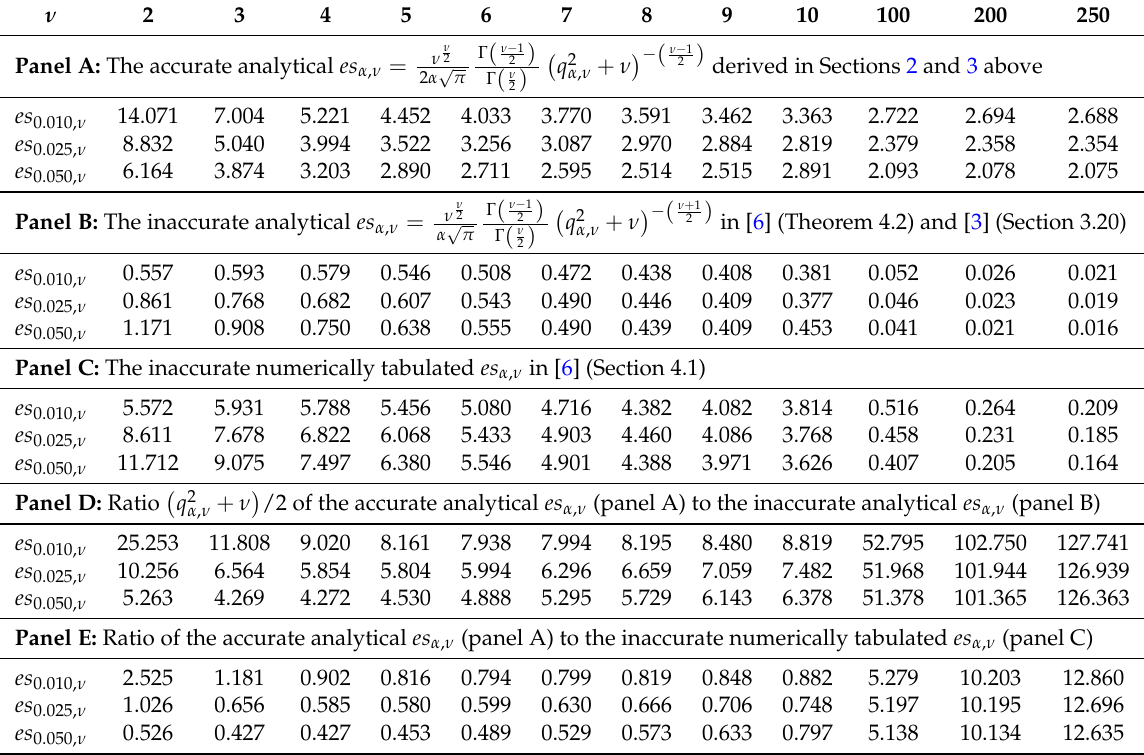
Table 1. Numerical comparison of the accurate versus inaccurate expressions for expected shortfall in the multivariate Student t case. The table reports the accurate analytical ( panel A ), inaccurate analytical ( panel B ), and inaccurate numerically tabulated ( panel C ) values of es α , ν , the multivariate Student t distribution governing the individual risky returns in a linear, mean-zero, and unit-scale portfolio, as well as the respective ratios of accurate versus inaccurate analytical ( panel D ) and accurate analytical versus inaccurate numerically tabulated ( panel E ) values across different tail quantiles α = 0.01, 0.025, 0.05 (different rows) and degrees of freedom ν = 2, 3, 4, 5, 6, 7, 8, 9, 10, 100, 200, 250 (different columns). The accurate analytical expression in panel A reflects the derivations in this paper (Theorems 1 and 2). The inaccurate expression in panel B is originally due to Kamdem [6] (Theorem 4.2) and is reproduced in Nadarajah et al. [3] (Section 3.20), while the inaccurate values in panel C are the ones numerically tabulated in [6] (Section 4.1).